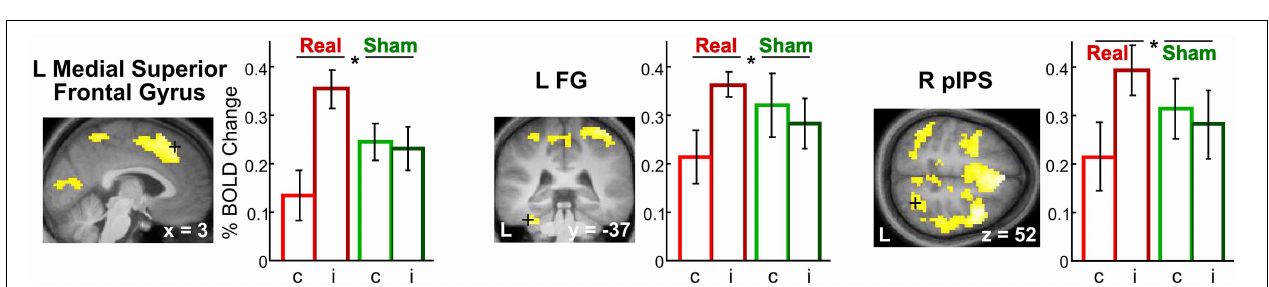
FIGURE 7 | Incongruency effects for unimodal visual matching (VV) evoked by rTMS conditioning. Only after real but not sham rTMS, regional activity in the L superior medial gyrus (MNI coordinates: x , y , z = 3, 32, 52) (left) , L FG ( − 36, − 37, − 26) (middle) , and R pIPS (27, − 58, 52) (right) was increased when a visual S2 was matched to an incongruent (i) as compared to a congruent (c) visual S1 (real > sham × incongruent > congruent). The same effects were found in the left pIPS.